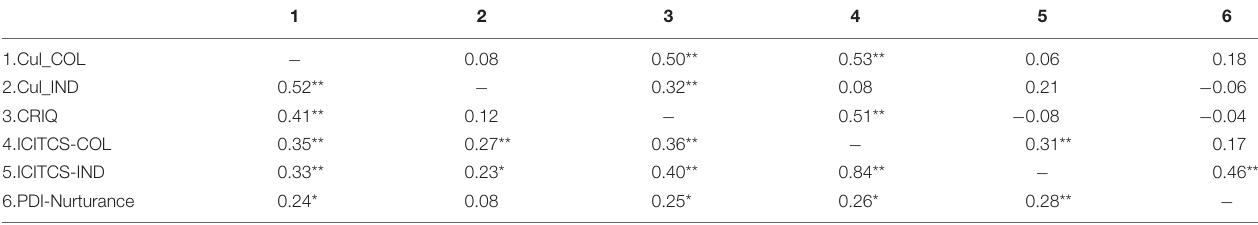
TABLE 4 | Correlations of measures for MC and European American mothers.